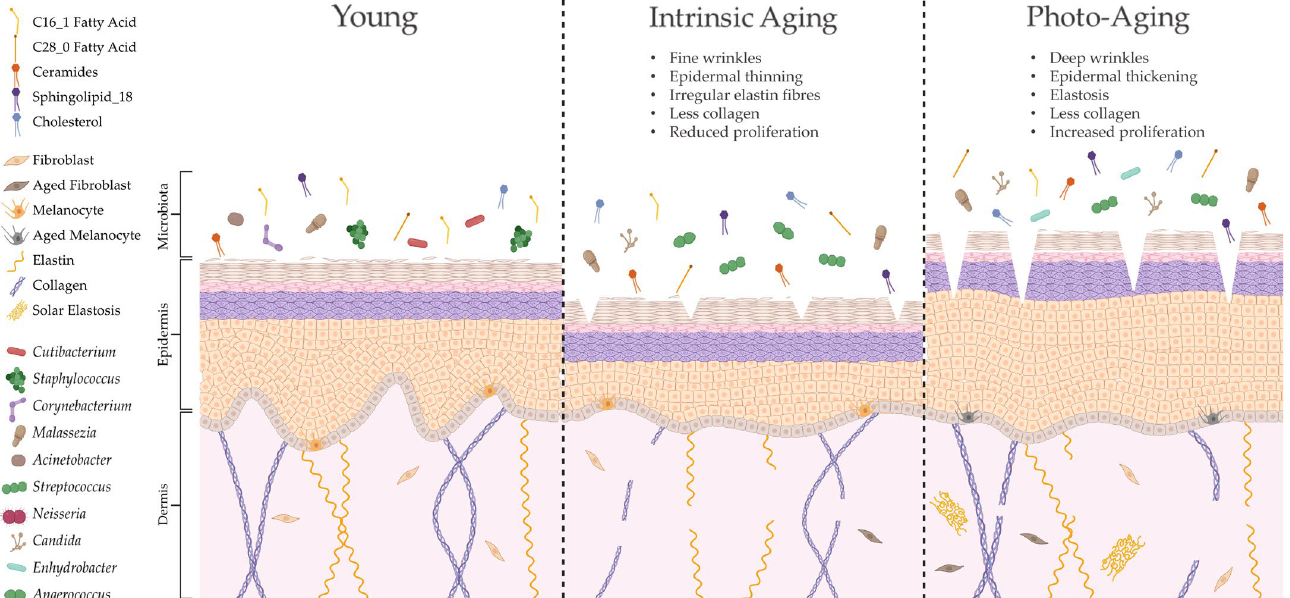
Figure 3. Ageing alters skin structure, function and microbial colonisation. Intrinsic ageing and photoageing cause differential alterations to cutaneous architecture and physiology, resulting in marked shifts in microbial composition [86,106]. Indeed, this altered skin microbiome may be shaped by specific modifications in lipid composition [9], which could further contribute to age-related cutaneous pathology. Created with biorender.com (accessed on 11 January 2023).